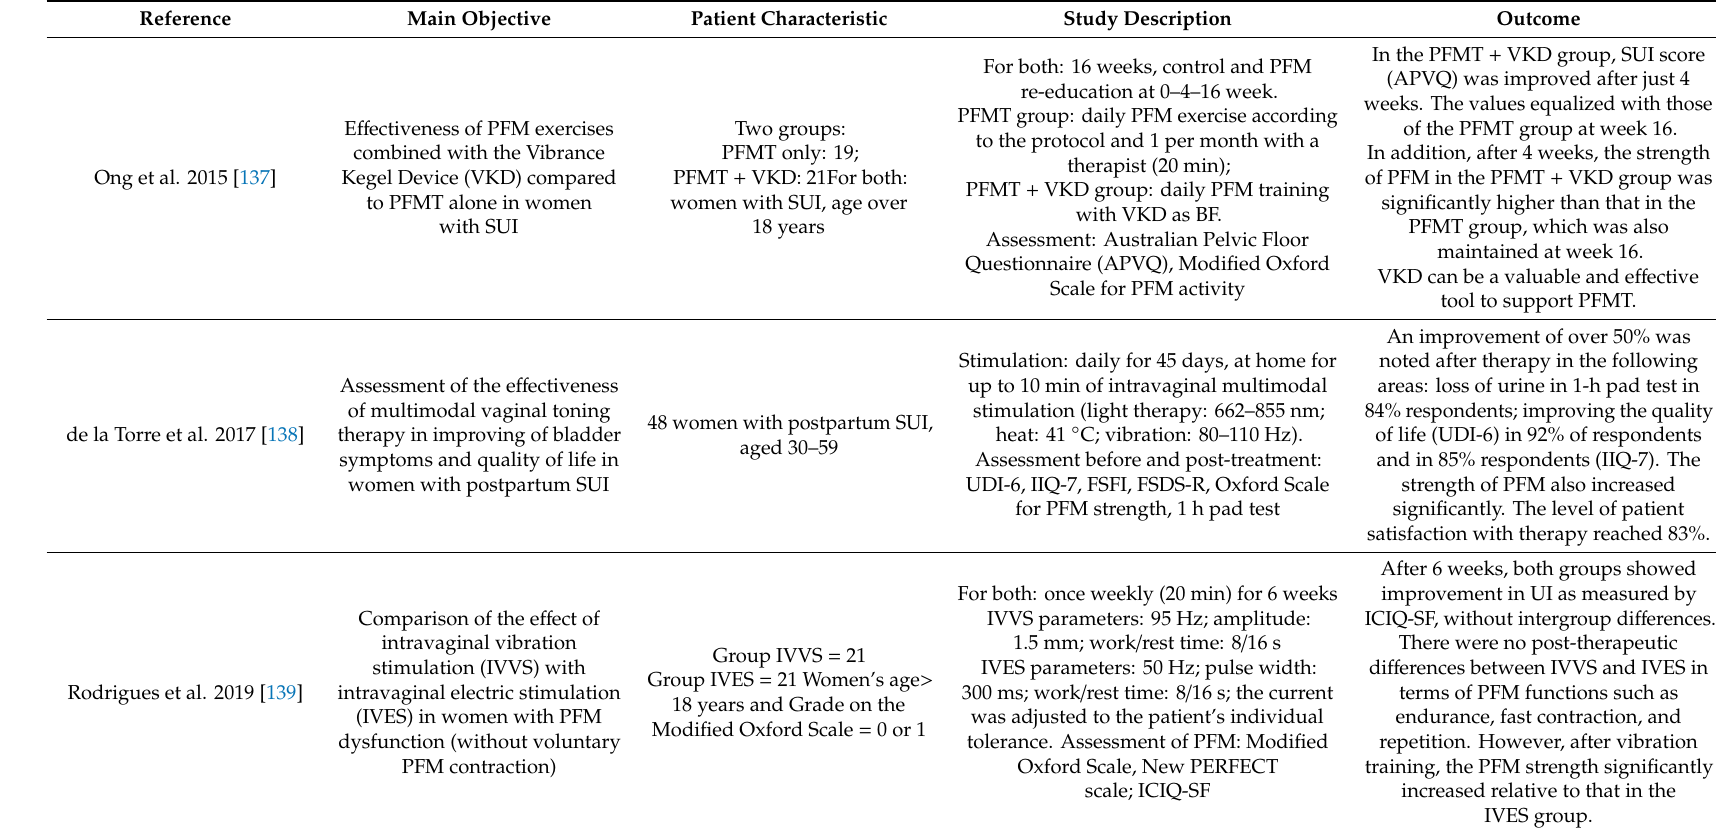
Table 6. Characteristic of selected studies on the e ff ects of direct vibration on the pelvic floor muscle (PFM) activity and / or severity of urinary incontinence (UI)